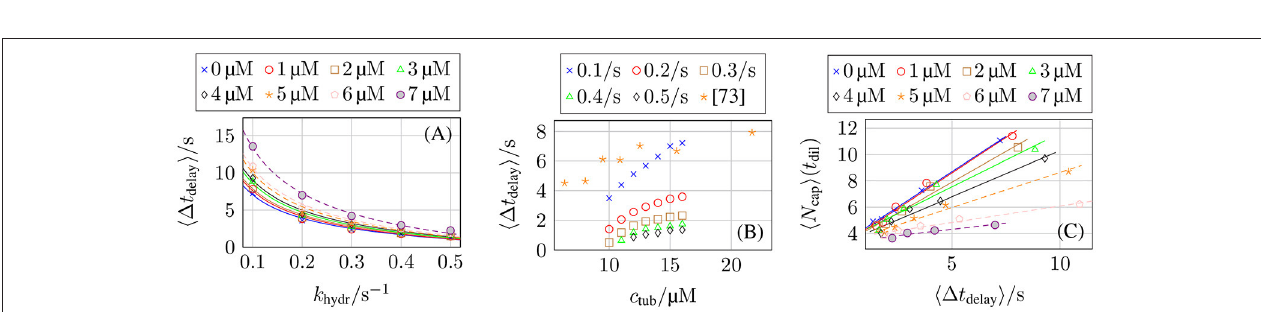
FIGURE 14 | Average post-dilution delay time h 1 t delay i as a function of (A) the hydrolysis rate k hydr for c tub = 16 µ M and different post-dilution GTP-tubulin dimer concentrations c dil and (B) the pre-dilution GTP-tubulin dimer concentration c tub for c dil = 0 µ M and different hydrolysis rates k hydr . The averaged data from Duellberg et al. [73] specified the pre-dilution growth velocity, which was converted to c tub for this plot. (C) Average GTP-cap length h N cap i at the time of dilution t dil as a function of the delay time h 1 t delay i for c tub = 16 µ M and different values of c dil